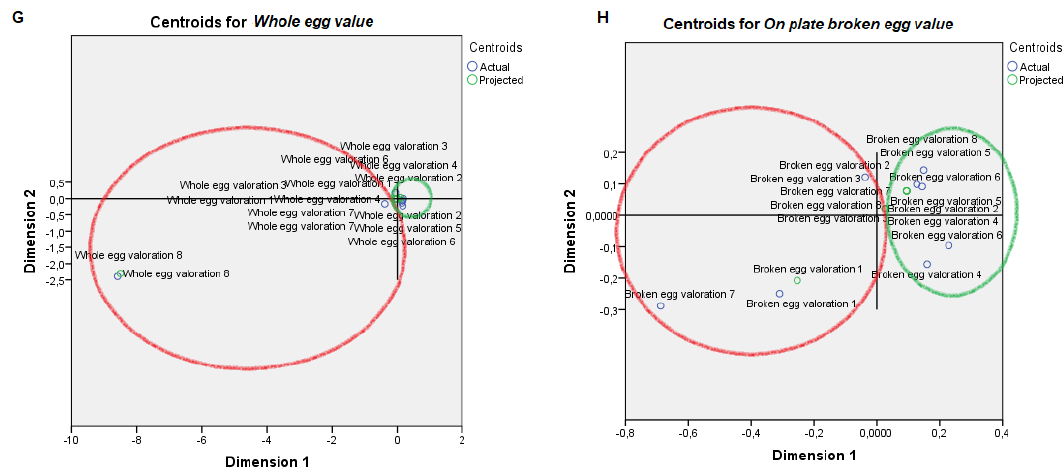
Figure 1. Object scores plot visualization of Professional Customer Profiles in regards egg sensory attributes, egg consumption non-affine profile or PPA (red), and affine profile or PPB (green). Egg sensory attributes were as follows: ( A ) Yolk color, ( B ) White color, ( C ) Odor, ( D ) Flavor, ( E ) Texture, ( F ) Global value, ( G ) Whole egg value and ( H ) On plate broken egg value.